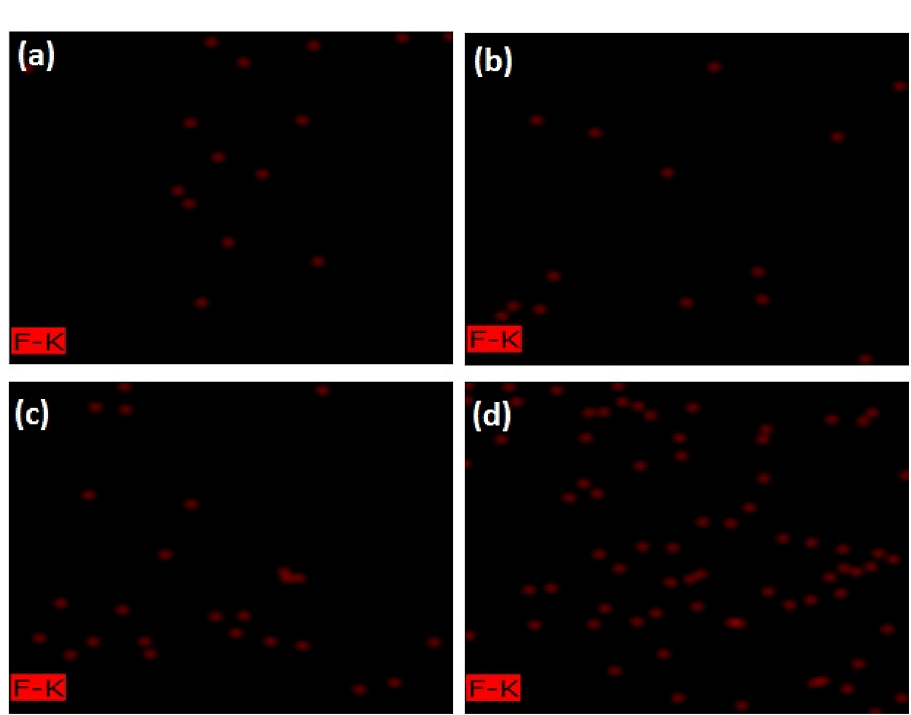
Figure 5. EDX mapping allows a qualitative comparison of the number of fluoride ions in tooth enamel between the control sample that received only FV and three other pieces impregnated with FV after various plasma processing. This image is the result of a 20 nm area scan of enamel. (a) C + FV, (b) Air-DBD + FV, (c) ArJ + FV, (d) He-DBDJ +